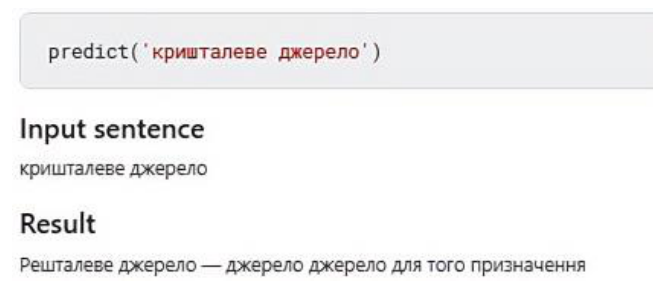
Figure 11. Neural network fails to understand the task.